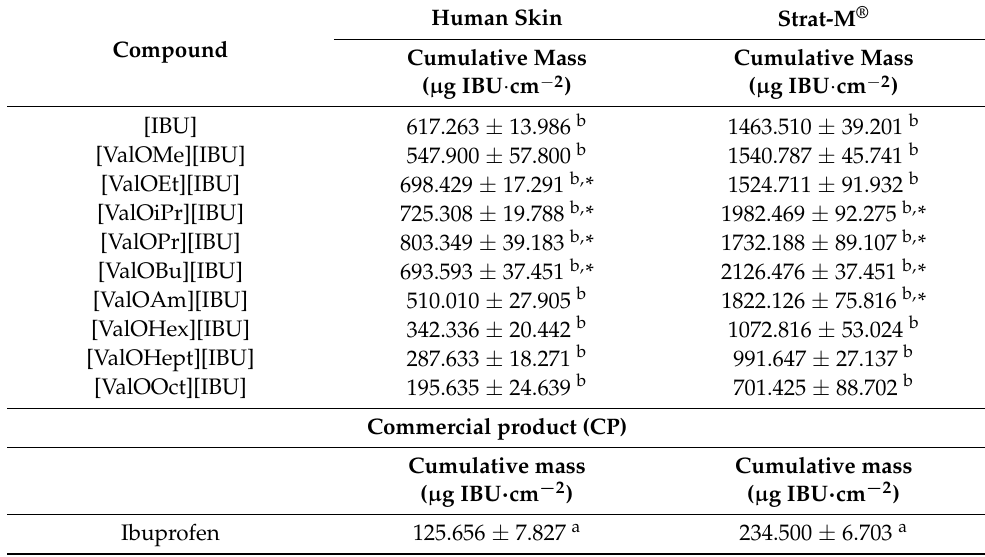
Table 3. The average cumulative mass of ibuprofen and its derivatives, expressed in mg IBU · cm − 2 , after 24 h permeation test from the Pentravan ® formulation and pure ibuprofen from commercial product through human SC and transdermal diffusion test model in